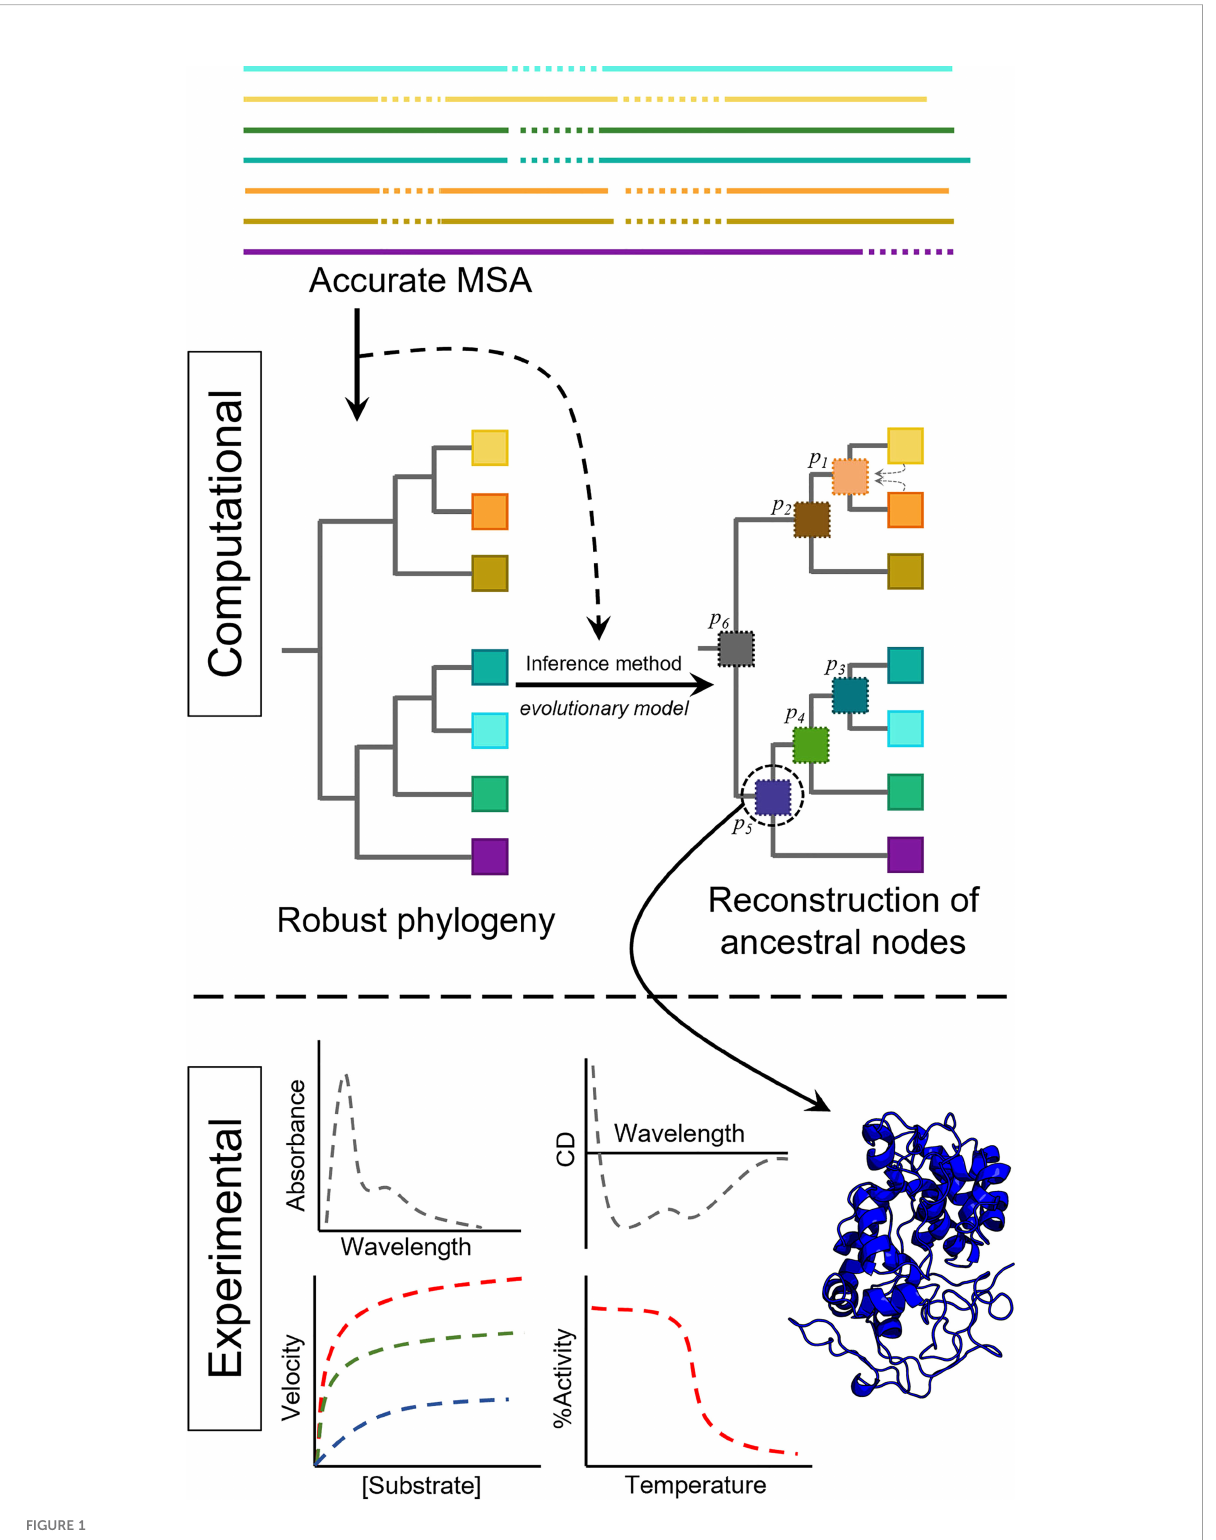
FIGURE 1 Simpli fi ed pipeline to resurrect ancestral proteins, including computational and experimental work. The sequences of the family of interest are aligned using accurate algorithms. The phylogeny is then obtained, and together with an evolutionary model and the multiple sequence alignment (MSA), the ancestral sequences at each node can be obtained. Once the ancestral sequence is selected, it can be resurrected (produced) in the laboratory to obtain the experimental data of interest (e.g. UV-vis or CD spectral properties, enzyme activity or thermal